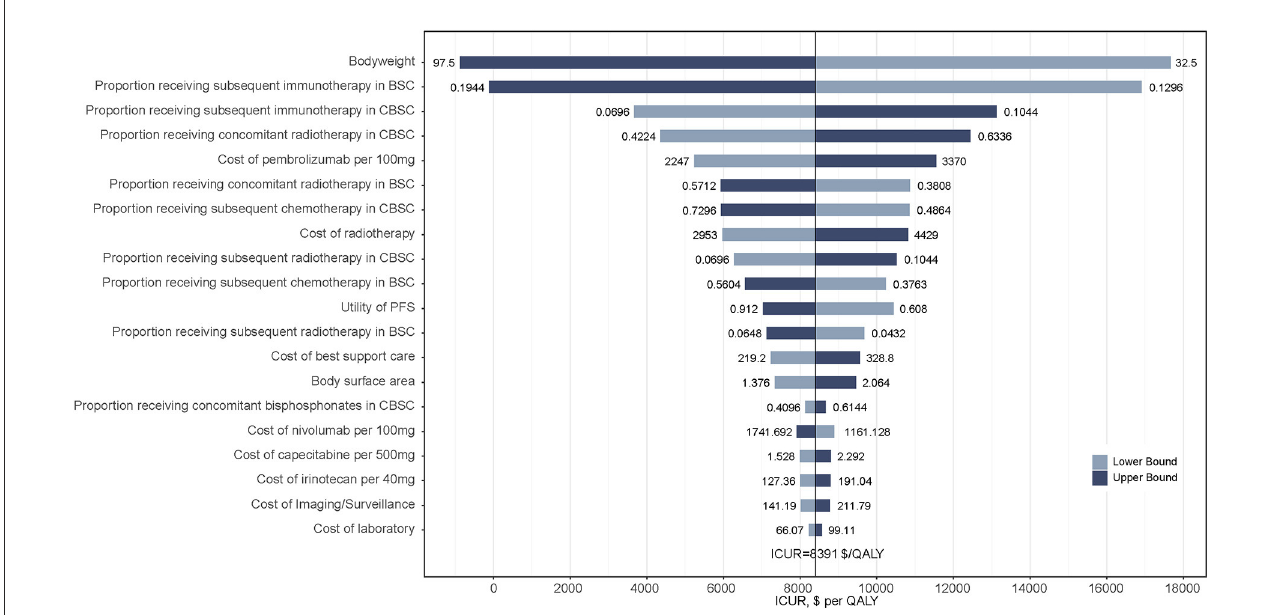
FIGURE3 Tornado diagrams derived from the one-way sensitivity analysis of CBSC vs. BSC. Only the top 20 parameters that had the most influence on the results were shown. The black solid line indicates the ICURs. The dashed line indicates the WTP threshold in China ($36 007/QALY). CBSC, Capecitabine maintenance therapy plus best supported care group; BSC, best supported care; ICUR, incremental cost-utility ratios; QALY, quality-adjusted life-year.